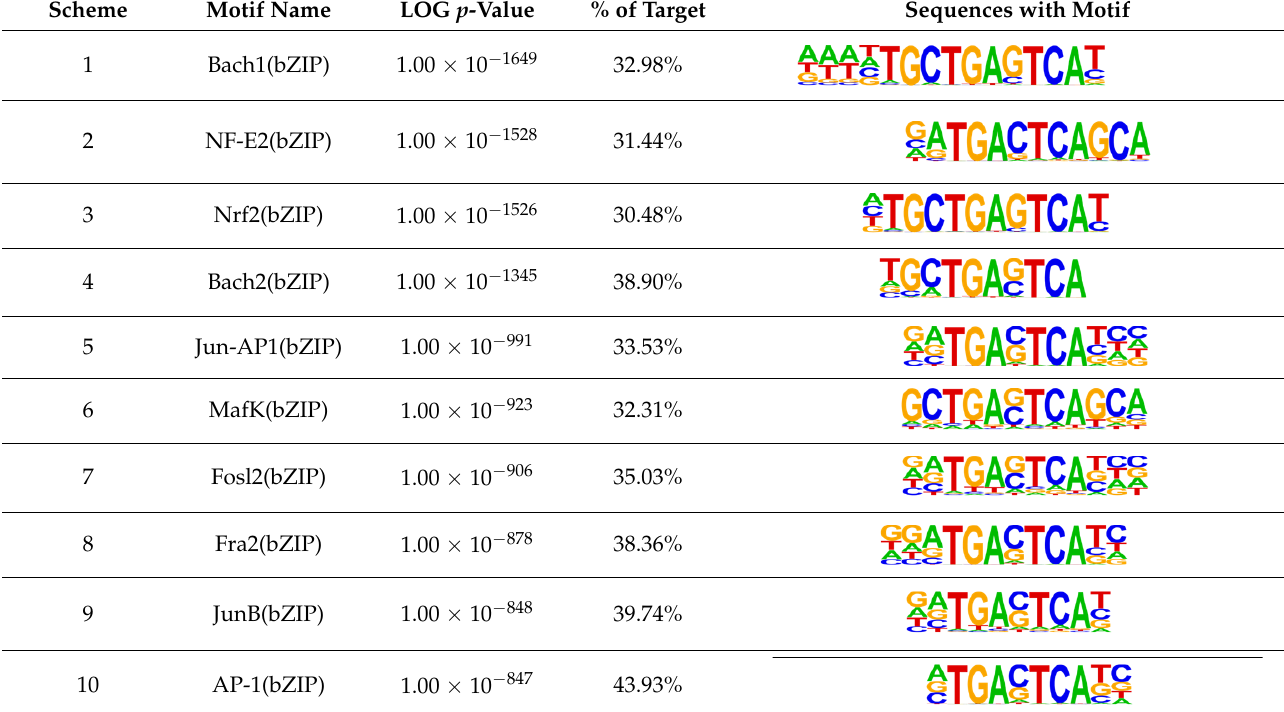
Table 1. Top 25 Bach1-associated DNA binding motifs identified from ChIP-seq data for Bach1 (GSM2086721).